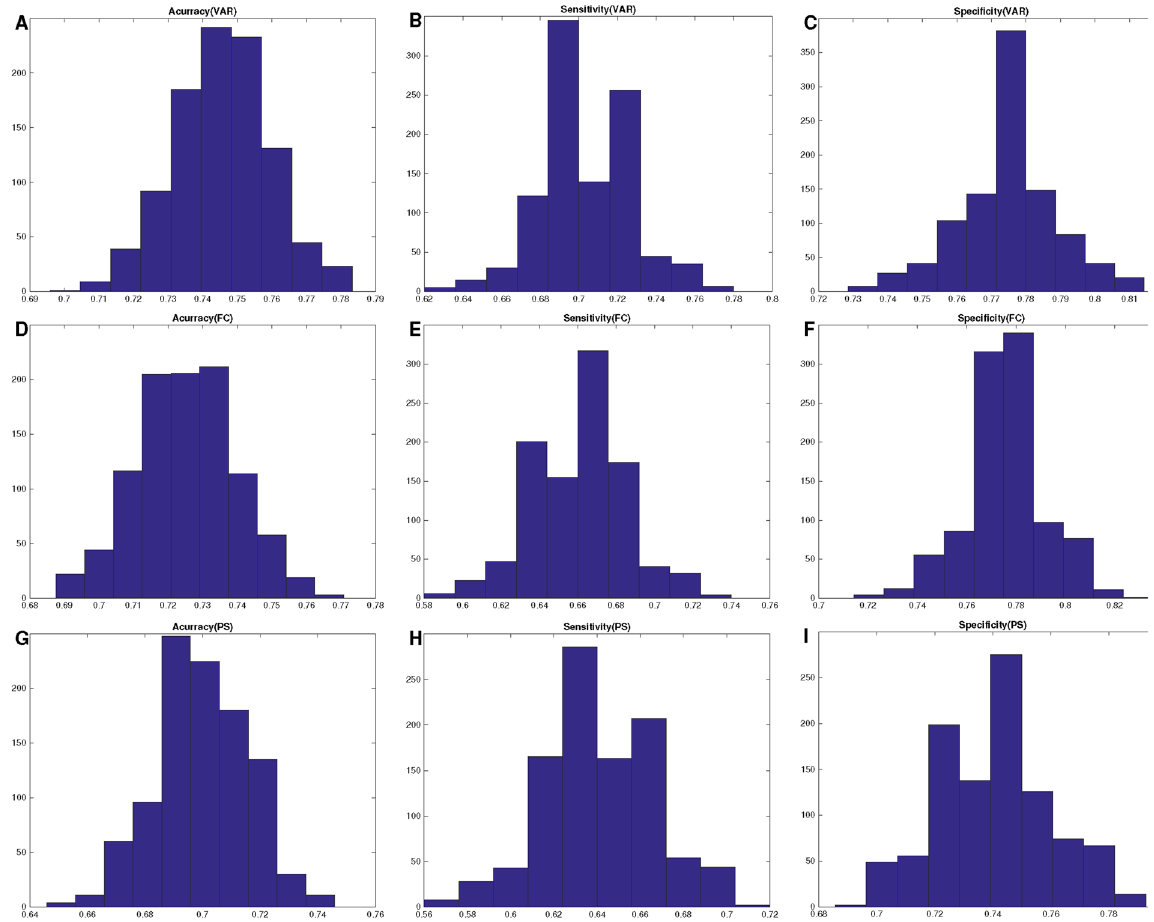
Figure 2. Histograms for performances of 10-folds classifications. Subfigure ( A ) denotes the total accuracy based on inter-ICN variability (VAR). Subfigure ( B ) denotes the sensitivity based on inter-ICN variability. Subfigure ( C ) denotes the specificity based on inter-ICN variability. Subfigure ( D ) denotes the total accuracy based on inter-ICN functional connectivity (FC). Subfigure ( E ) denotes the sensitivity based on inter-ICN FC. Subfigure ( F ) denotes the specificity based on inter-ICN FC. Subfigure ( G ) denotes the total accuracy based on inter-ICN phase synchrony (PS). Subfigure ( H ) denotes the sensitivity based on inter-ICN PS. Subfigure ( I ) denotes the specificity based on inter-ICN PS.